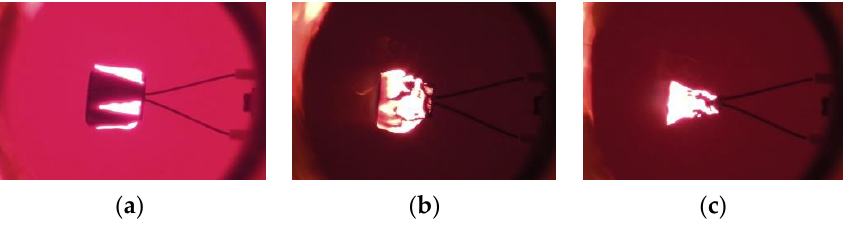
Figure 5. Particle combustion at a furnace temperature of 800 °C and air flow velocity of 125 ms −1 , type A holder. Figures below the pictures are temperatures at the center of a particle. ( a ) 173 °C, ( b ) 202 °C, ( c ) 285 °C.